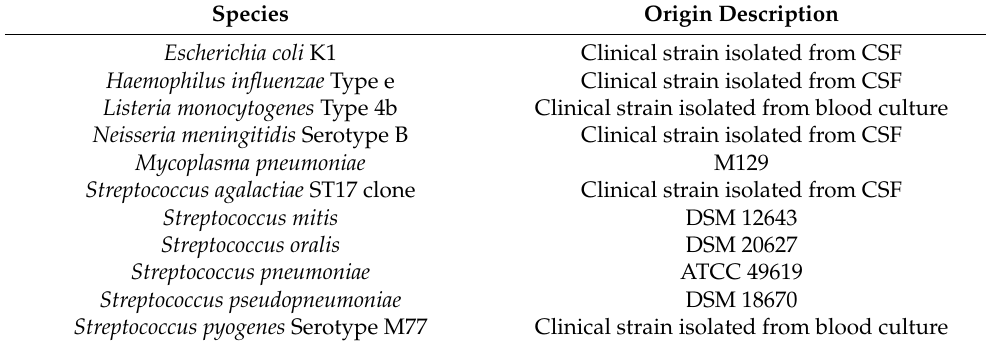
Table 1. Bacterial strains used in the